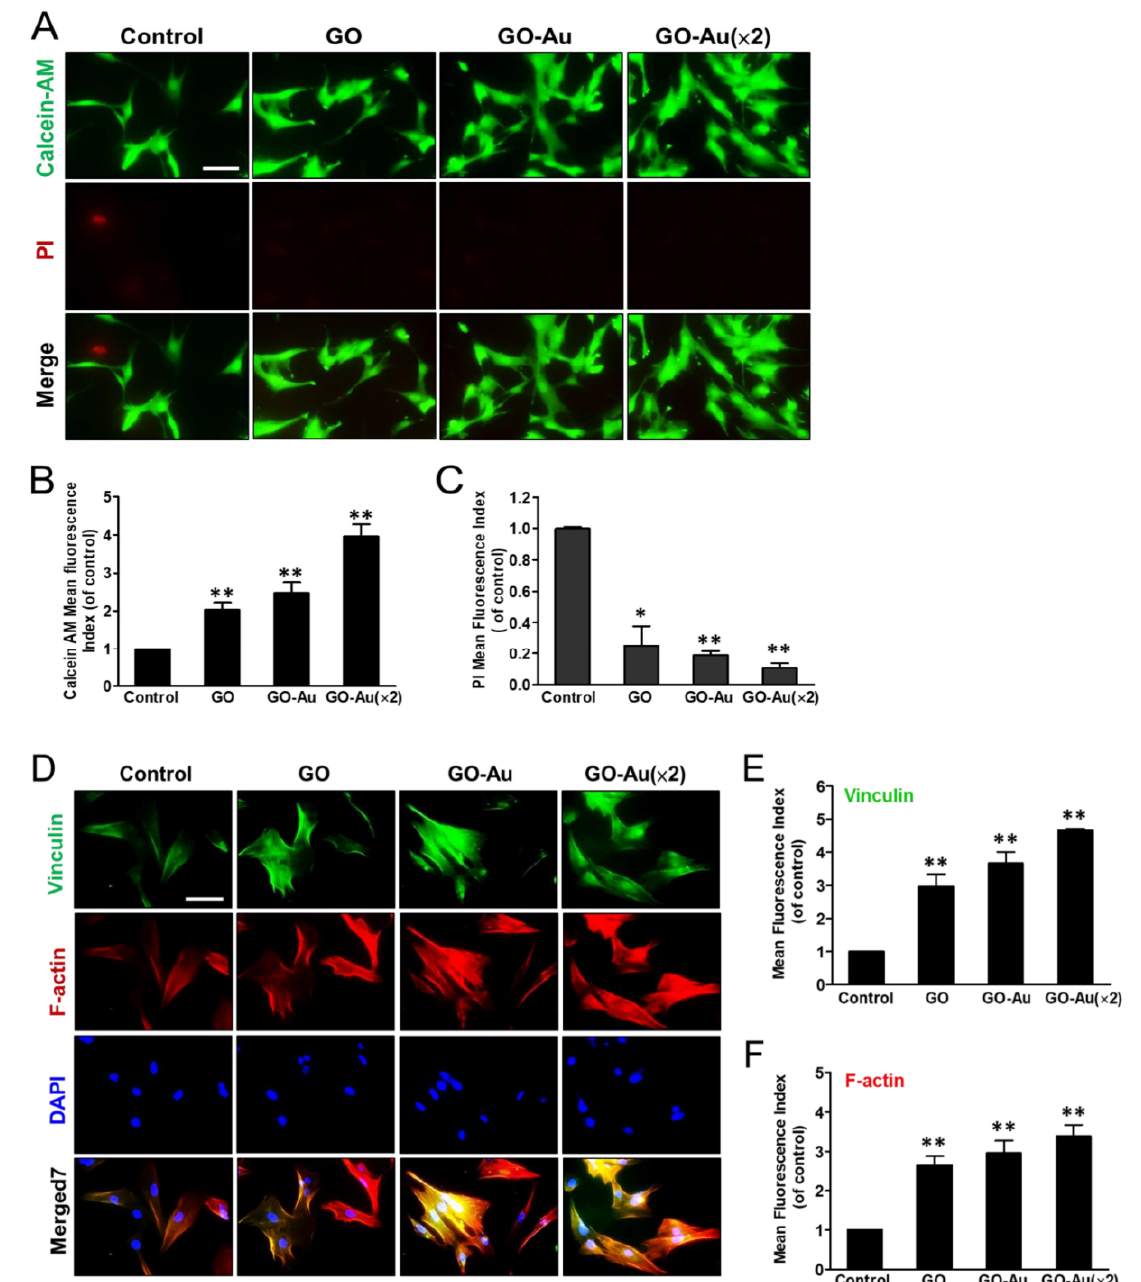
Figure 2. Effects of different materials on MSCs viability using calcein-AM/PI co-staining assay. Cells were cultured in cover slide deposited with nanomaterials including GO, GO-Au, and GO-Au ( × 2) for 24 h. Cells were, then, co-stained with calcein-AM dye and PI, and cell viability was observed using a fluorescence microscopy. ( A ) Both the live cells and dead cells were presented in green and red fluorescence images, respectively. The fluorescence intensity in either ( B ) calcein-AM (live cells) or ( C ) PI (dead cells) with further quantification and analysis using Image J software. The control group is indicated as a glass cover slide. Scale bars, 20 µ m. Data were presented as the mean ± SD, * p < 0.05 and ** p < 0.001. Effects of different materials on MSCs adhesion ability and cell morphology: ( D ) After cells were cultured on various nanomaterials of GO, GO-Au, and GO-Au ( × 2) for 24 h, then, cells were analyzed for cell adhesion capacity using an immunofluorescence assay and recognized with anti-vinculin antibody (green) and cytoskeletal F-actin phalloidin dye (red). Nuclei were stained with DAPI (blue). The representative fluorescent intensity of ( E ) vinculin and ( F ) F-actin were determined from three independent results. Scale bar, 20 µ m. Data were presented as the mean ± SD, ** p < 0.001.